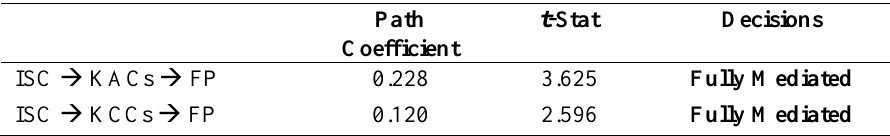
Path t -Stat Decisions Coefficient